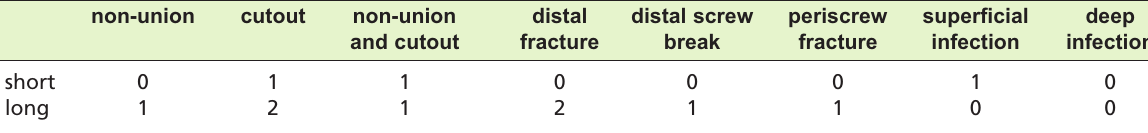
Complications of Fixation with Short and Long PFNA Table III: